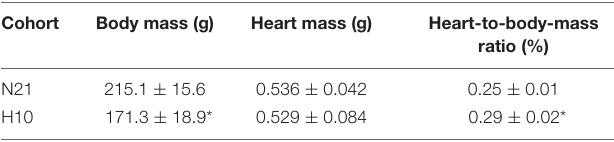
TABLE 2 | Comparison of body and heart masses of juvenile snapping turtles from normoxic (21% O 2 ; N21) and hypoxic (10% O 2 ; H10) development. Cohort Body mass